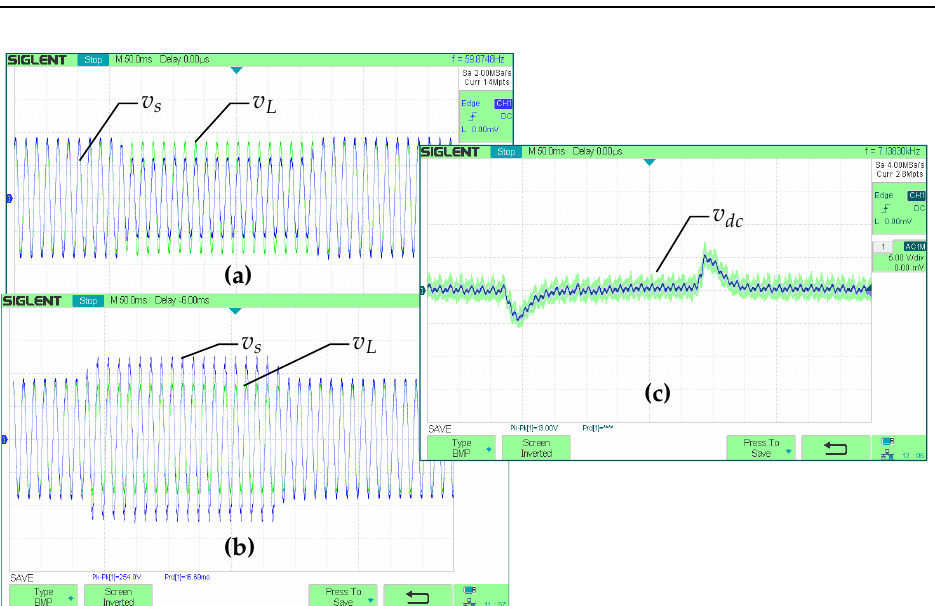
Figure 10. Experimental results of amplitude variations in the grid voltage: ( a ) sag response, ( b ) swell response, and ( c ) DC-link